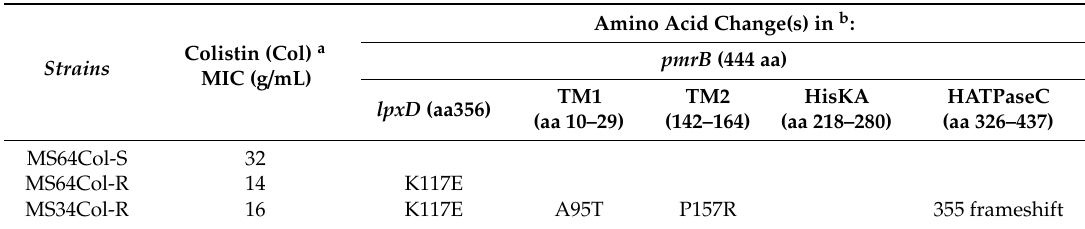
Table 3. Amino acid changes or mutations in pmrB and lpxD in colistin-resistant clinical and laboratory-induced strains (compared to their parental wild-type strain ATCC